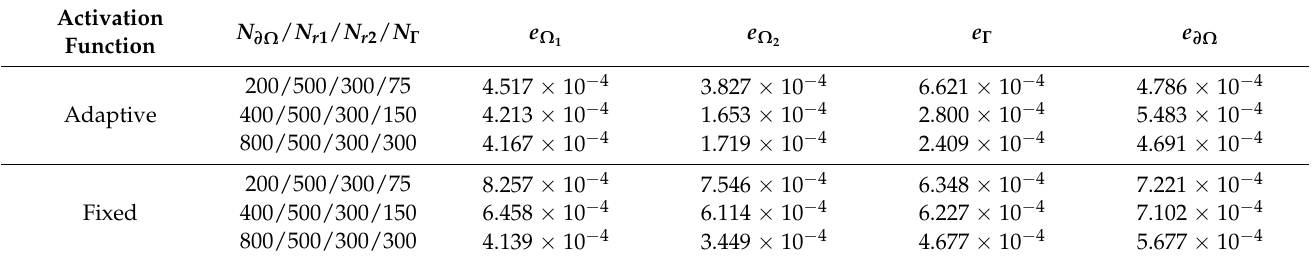
Table 3. Comparison of errors by adaptive and fixed activation function strategies with different numbers of training points for Example 2.